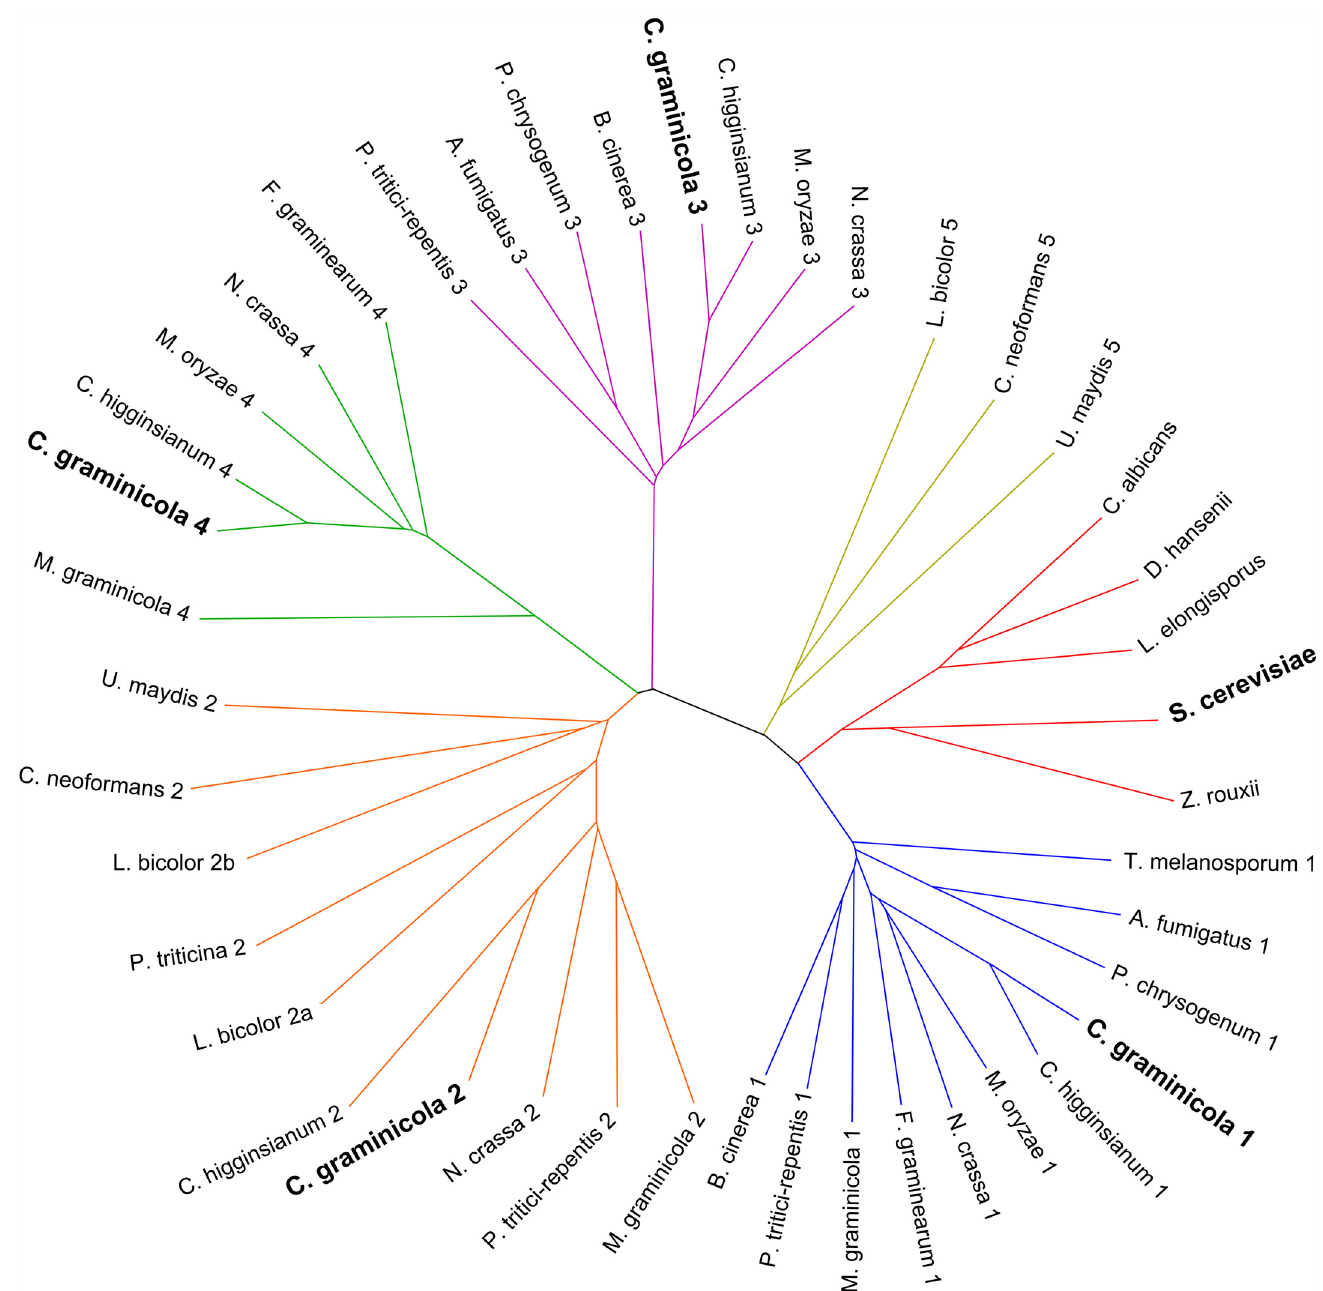
Fig 2. Phylogenetic tree of fungal TRP proteins. Red: yeast TRPYs; blue, orange, violet and green: TRPF groups 1, 2, 3, and 4, each containing a C . graminicola homologue; yellow: TRPF group not containing a C . graminicola homologue.